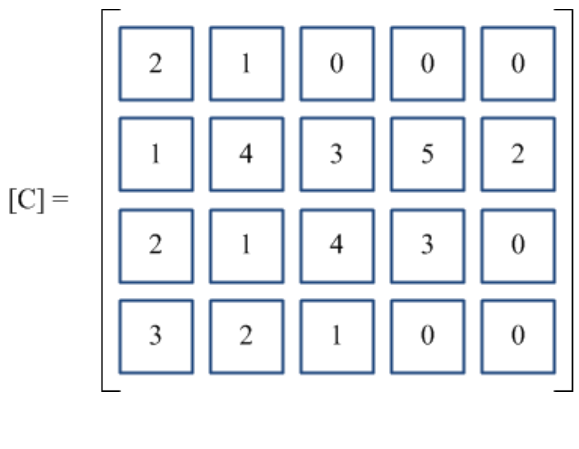
Figure 2. GARS matrix-encoding